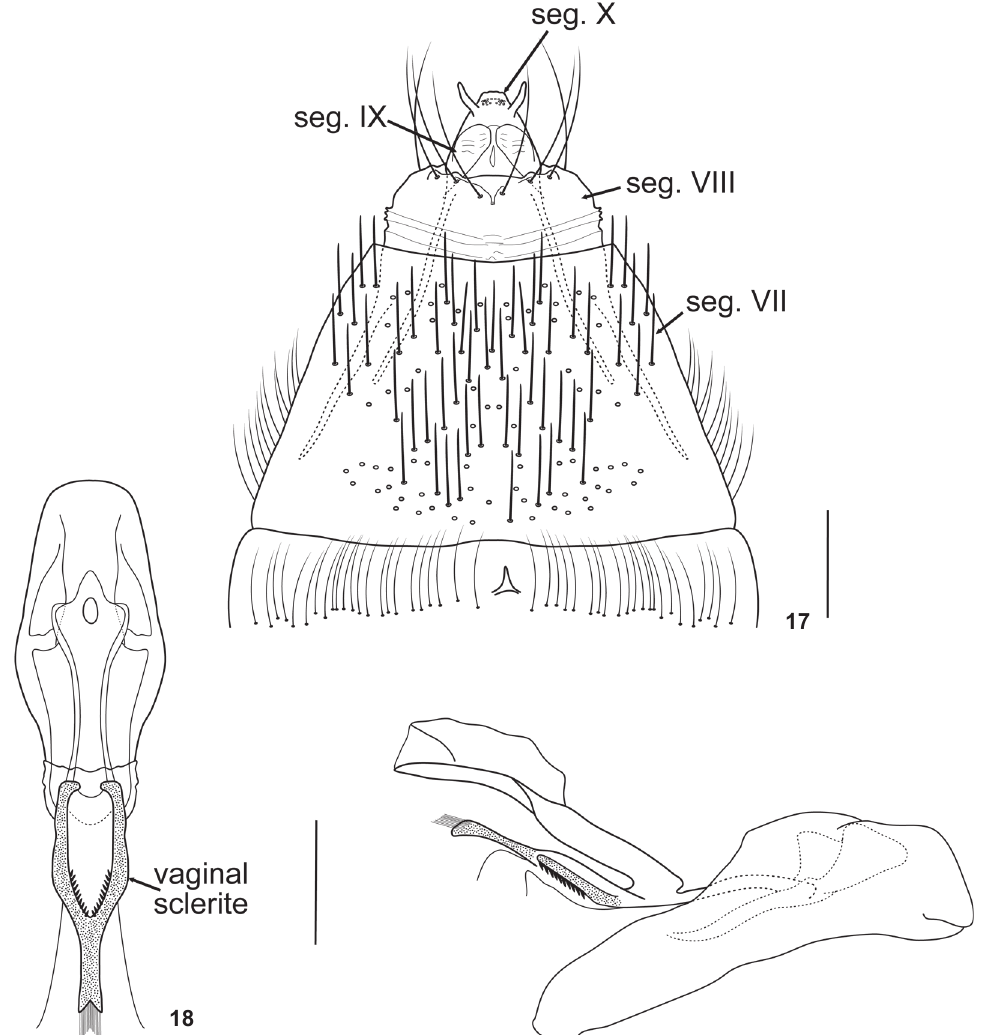
Figures 17-19. Costatrichia fluminensis sp. nov. , female genitalia: (17) ventral view; (18) bursa copulatrix, ventral view; (19) bursa copulatrix, lateral view. Scale bar = 0.1